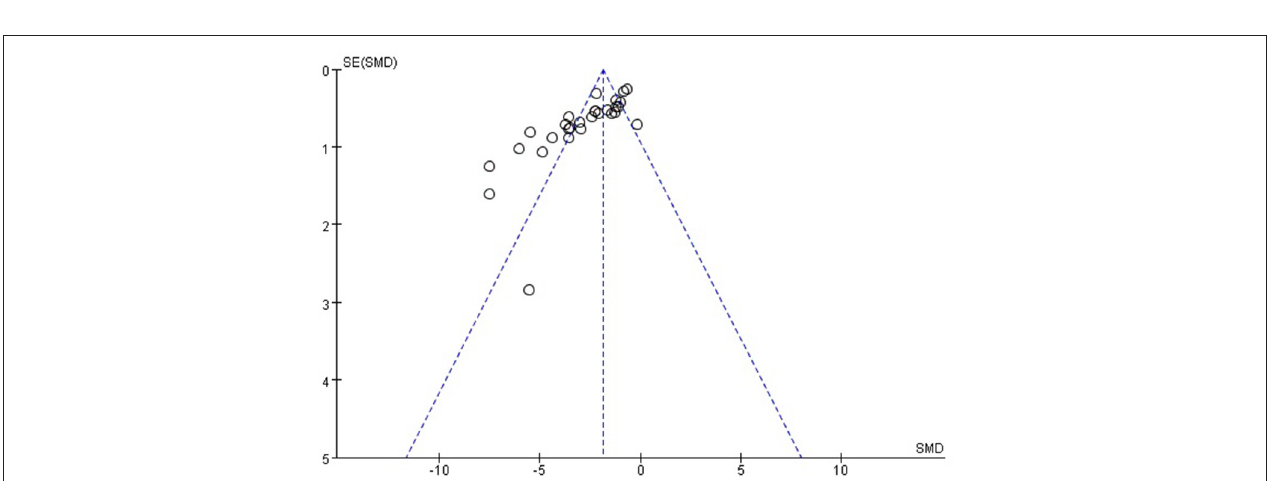
FIGURE 11 | The funnel plot: effects of Rhodiola rosea L. for decreasing the escape latency in MWM.